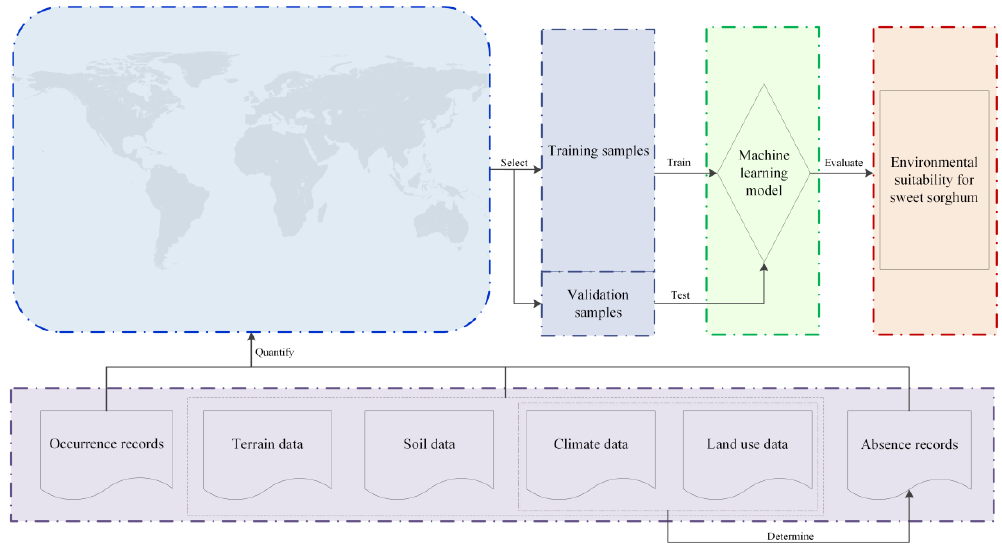
Figure 1. A flow chart.